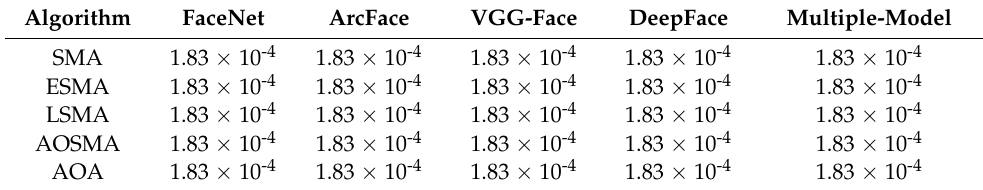
Table 11. p -values for S 2 SMA versus other competitors on XM2VTS.